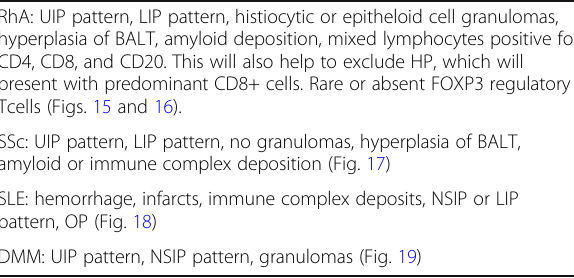
Table 3 Features Combined features of some chronic autoimmune